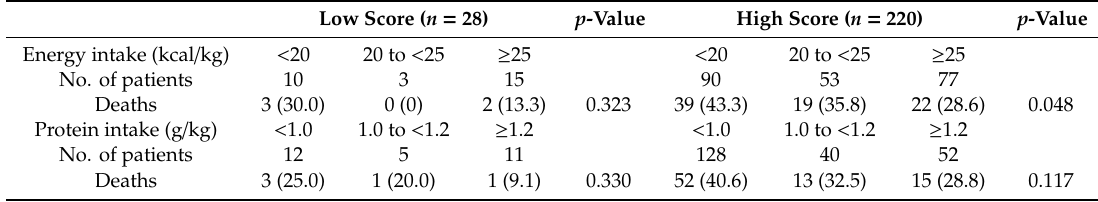
Table 2. Relation between nutrition intake and 28-day mortality.